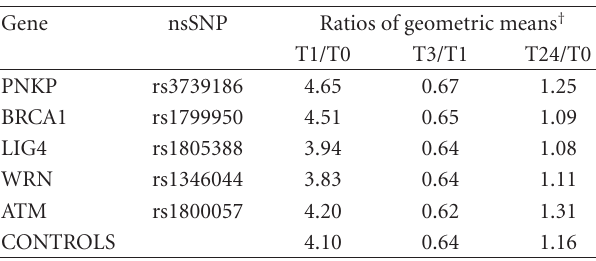
Table 3: Comparison of the number of foci at various time points (T0, before irradiation; T1, T3, T24, respectively, 1 hour, 3 hours, 24 hours, following